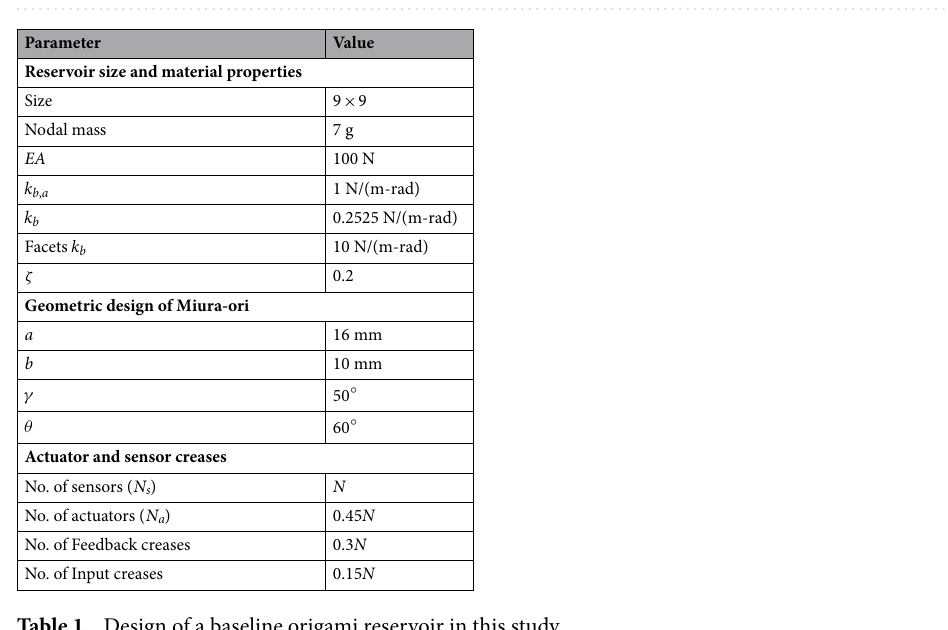
Figure 2. The setup of physical reservoir computing with origami. ( a ) The training phase. The feedback creases receive the reference (or targeted) output z ( t ); while white noise is added to the reservoir state matrix ¯ (cid:31) before calculating output weights W out ; ( b ) The closed-loop phase. The output weights obtained in the training phase are used to calculate the current output, which is fed back to the feedback creases.